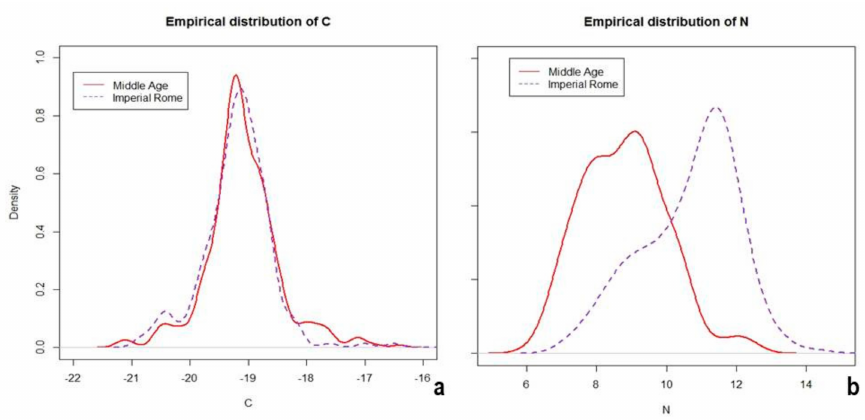
Figure 2. Empirical distribution of δ 13 C ( a ) and δ 15 N ( b ) in Roman and Medieval analyzed popula- tions from Latium (Italy).